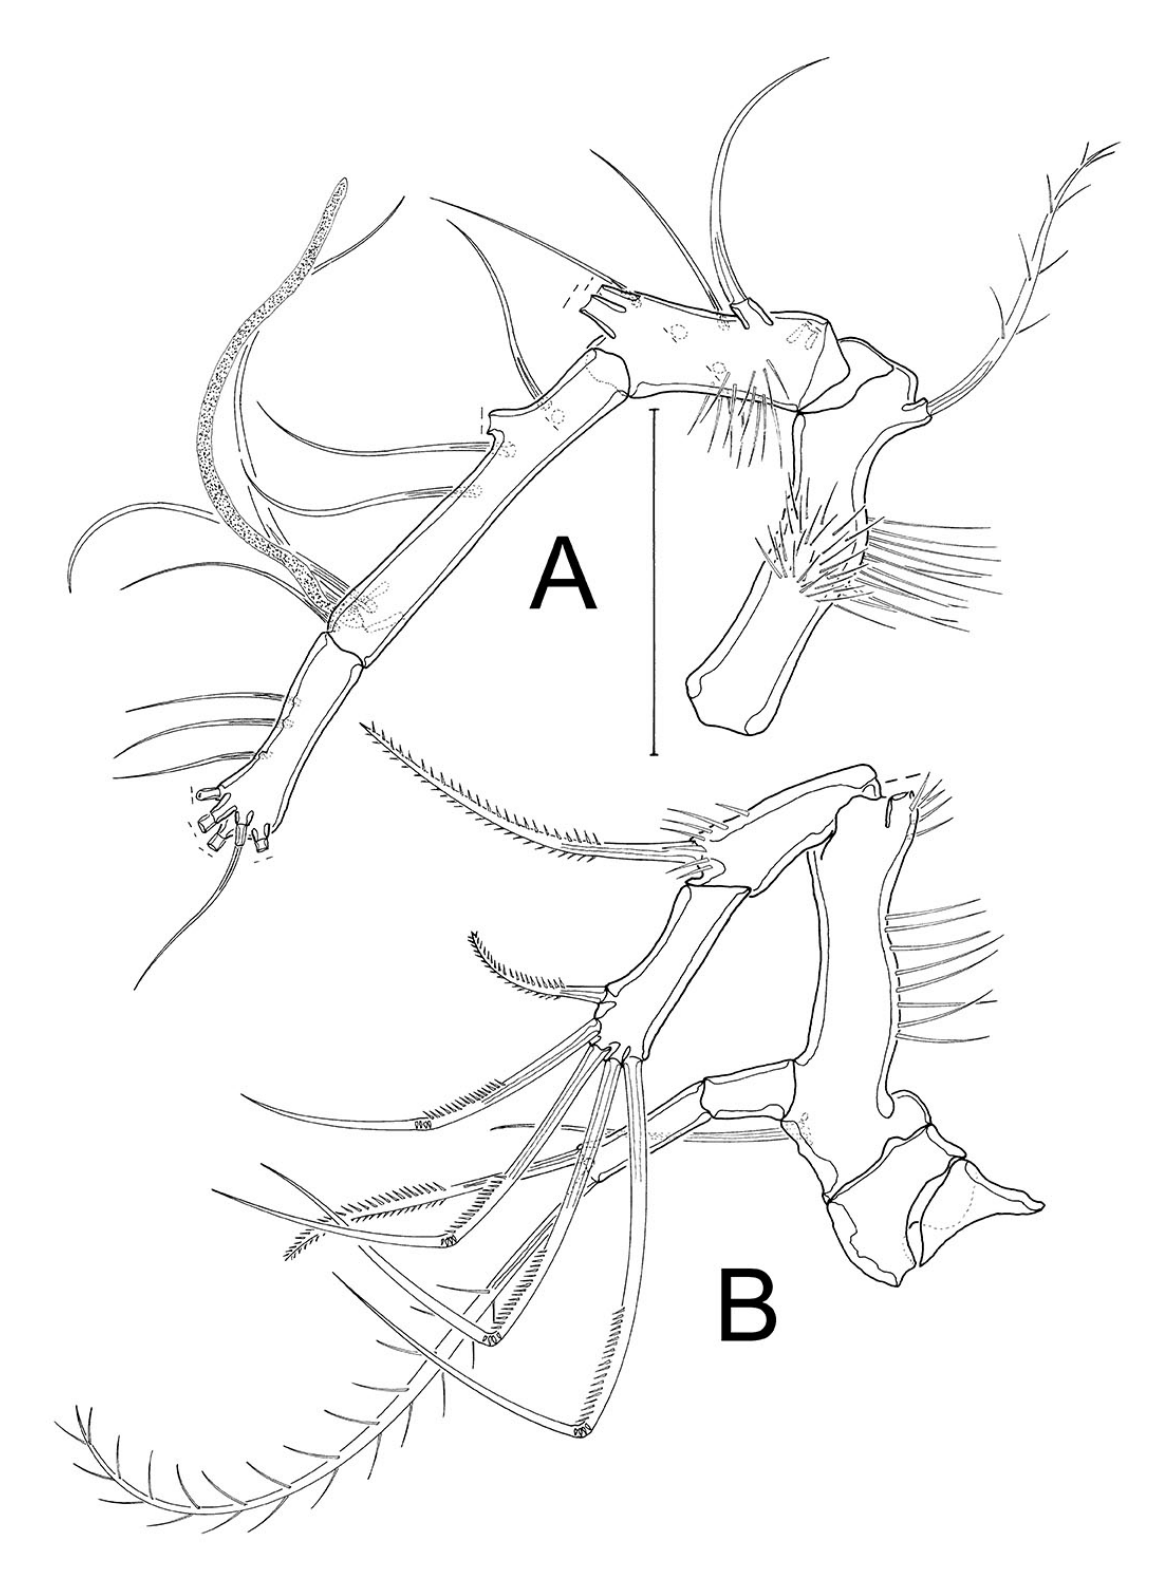
Fig. 10. Paratouphapleura aaroni gen. et sp. nov. A . Female holotype (SMF 37270/1), A1. B . Female paratype 3 (SMF 37273), P1. Scale bar: 50